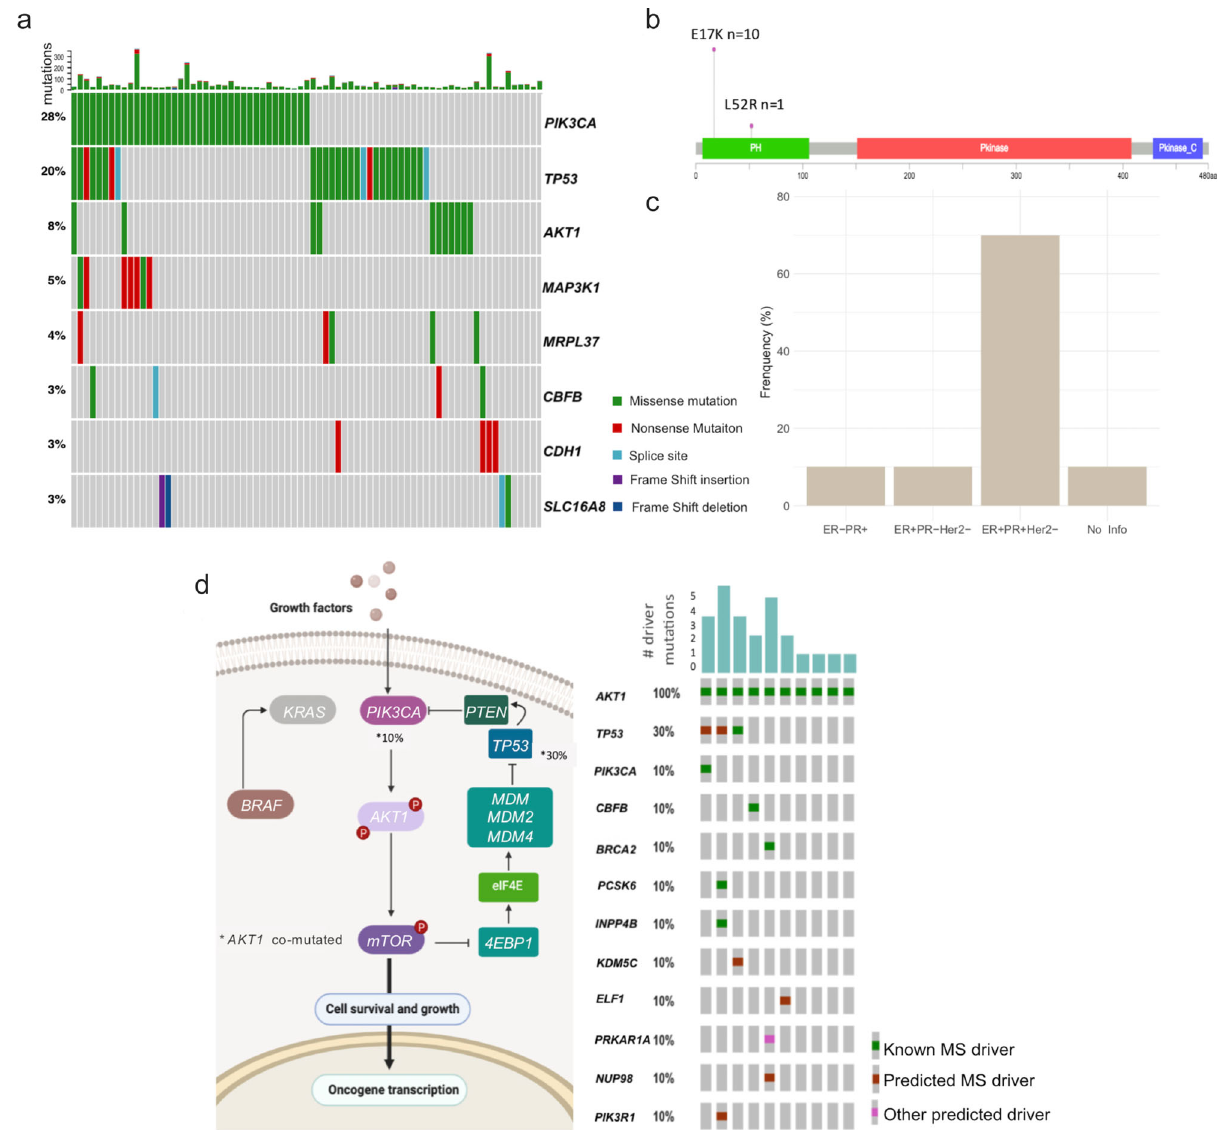
Fig. 4 Mutational panorama of HM breast cancer tumors. a Oncoplot of signi fi cantly non-silent mutated genes in HM tumors computed by MutSig ( q- value < 0.1). The heatmap represents individual mutations in patient samples, color-coded by type of mutation as illustrated by the fi gure legend. Percentages refers to the fraction of tumors with at least one mutation in the speci fi ed gene. p -values were determined by testing if the observed mutations in a gene signi fi cantly exceed the expected background model. p -values were adjusted by false-discovery rates, only top 10 genes with adjusted p -value ≤ 0.1 were reported. b Lollipop plots of non-silent mutations detected in AKT1 gene in HM women and their distribution in the body gen. c Proportion of tumor samples in HM dataset, separated according to their immunochemical classi fi cation, harboring E17K- AKT1 mutation. d Fraction of mutational alterations presented in the PIK3CA/AKT/mTOR axis (left panel, % of samples co-mutated with AKT) visualized with PathwayMapper and co-mutated driver alterations in AKT mutated tumors (right panel MS =